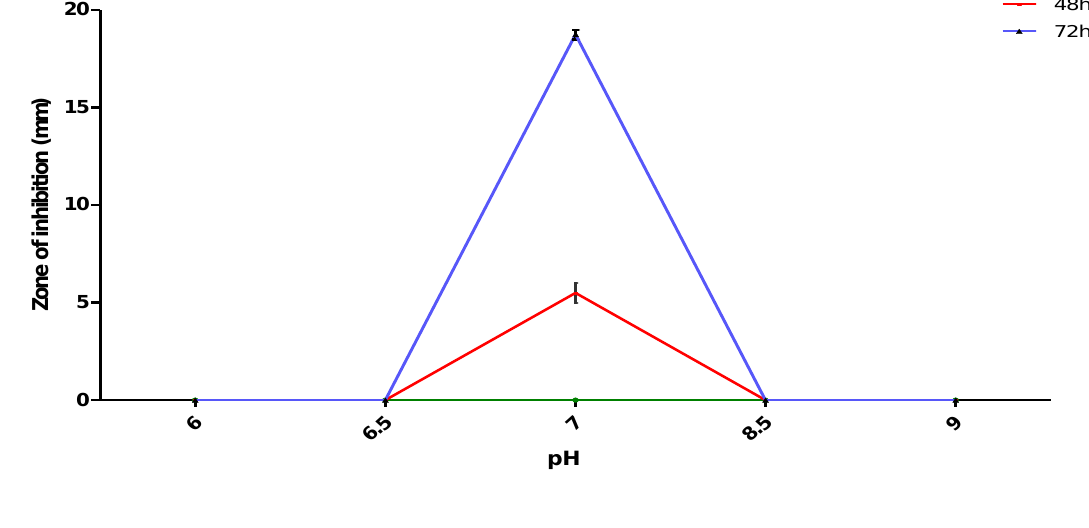
Figure 8. Effect of pH on the haemolytic activity of Bacillus